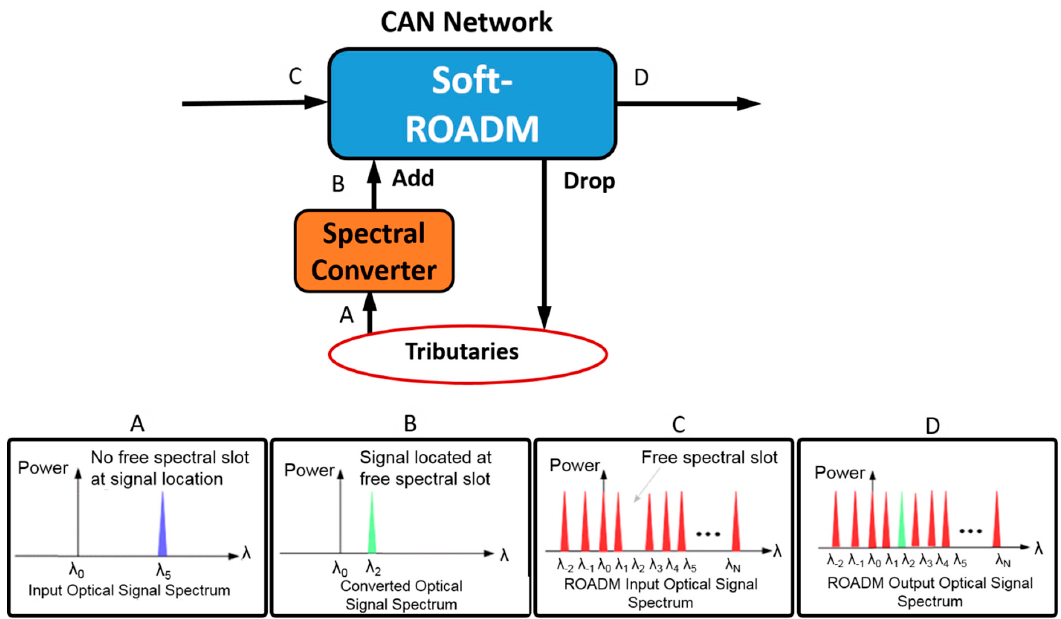
Figure 10. Example of spectral converter application in a CAN. (Insets shows spectra at indicated ports).